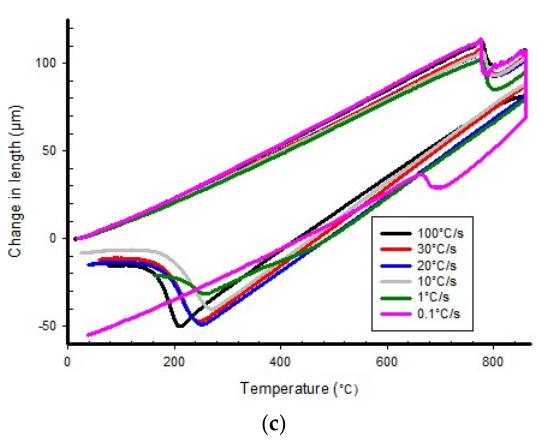
Figure 3. Dilatometric graphs of ( a ) 55Cr3, ( b ) 54SiCr6, and ( c ) 52CrMoV4 at various cooling rates.